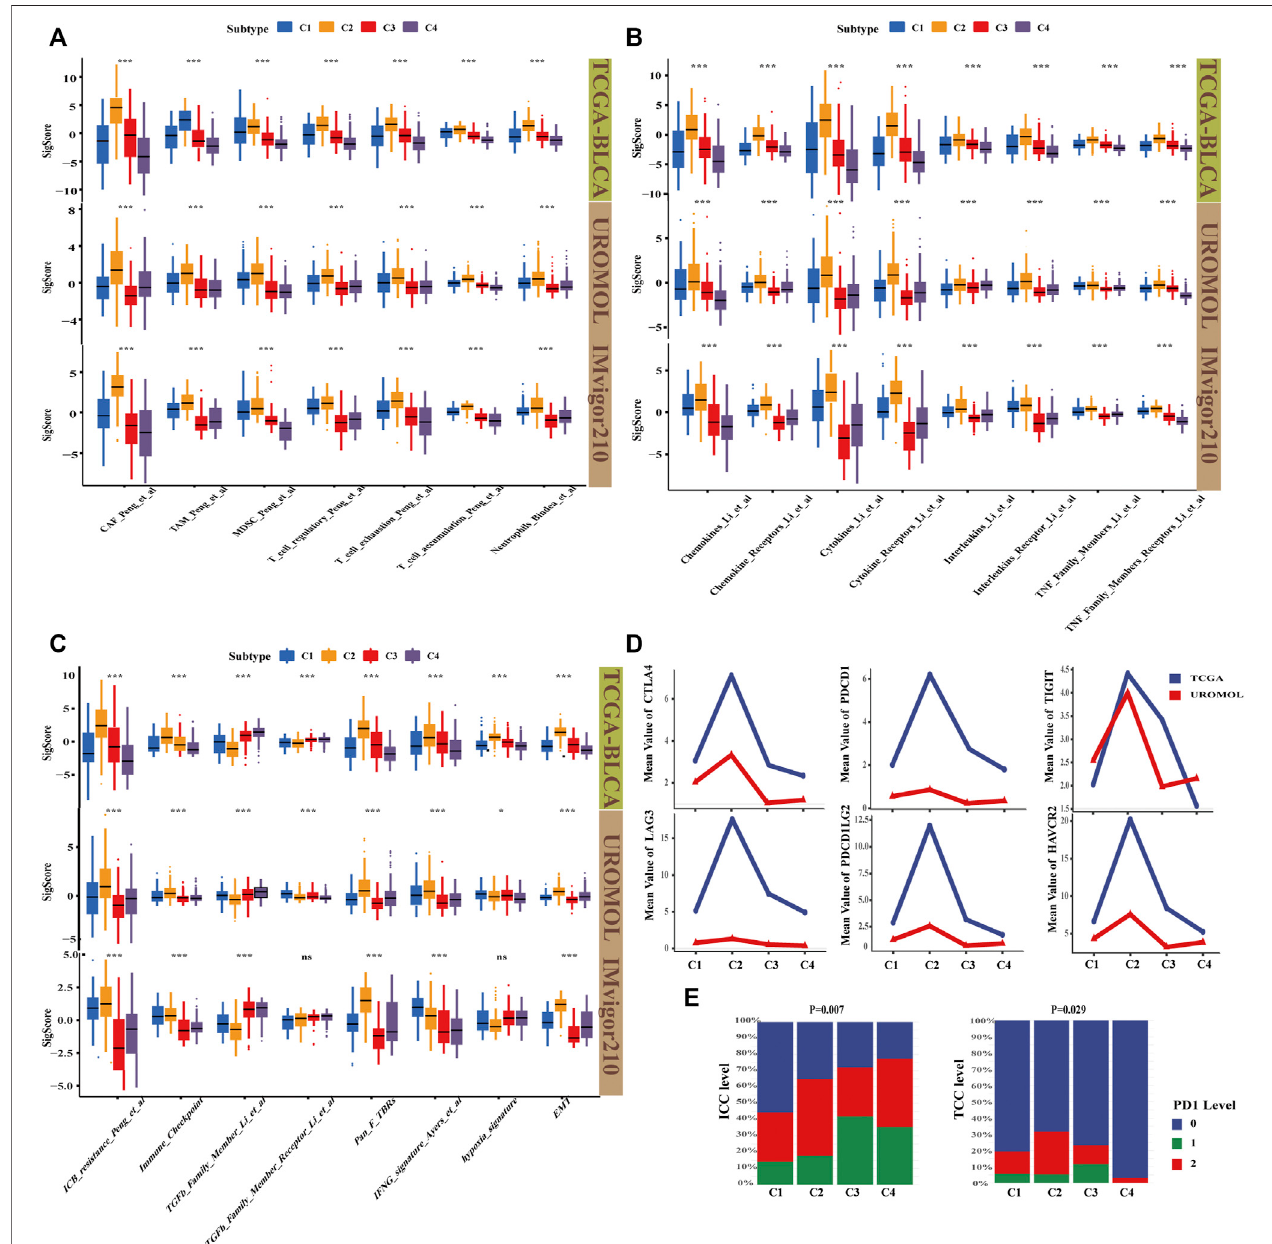
FIGURE 4 | Characterization of TME, in fl ammation, and immunotherapy heterogeneity by signature in four subtypes. (A) Boxplot shows TME signature of four subtypes;C4hadthehighestimmuneeffectiveandthelowestimmunosuppressiveandimmune exhaustedsignature,whereasC2wastheopposite.C1had arelatively high immunosuppressive environment. Kruskal – Wallis (K – W) test was performed among four subtypes. * p < .05, ** p < .01, and *** p < .001. (B) Boxplot shows in fl ammation signature correlated with chemokine, cytokine, interleukin, and TNF family. C2 had the highest tumor-associated in fl ammation, whereas C4 had the lowest. C1and C3had the median level.K – W test wasperformed amongfour subtypes. * p < .05, ** p < .01, *** p < .001. (C) Boxplot showed immunotherapy signature, immune-resistant related signature and EMT signature were the highest in C4 but the lowest in C2. K – W test was performed among four subtypes. * p < .05, ** p < .01, and *** p < .001. (D) The line graph shows the average gene expression of the six immune checkpoints, C2 had the highest level in all six immune checkpoints. (E) Hierarchical bar graph showed the PD1 level in immune cells (ICC) and tumor cells (TCC) in the IMvigor210 cohort (chi-square test, p < .05).